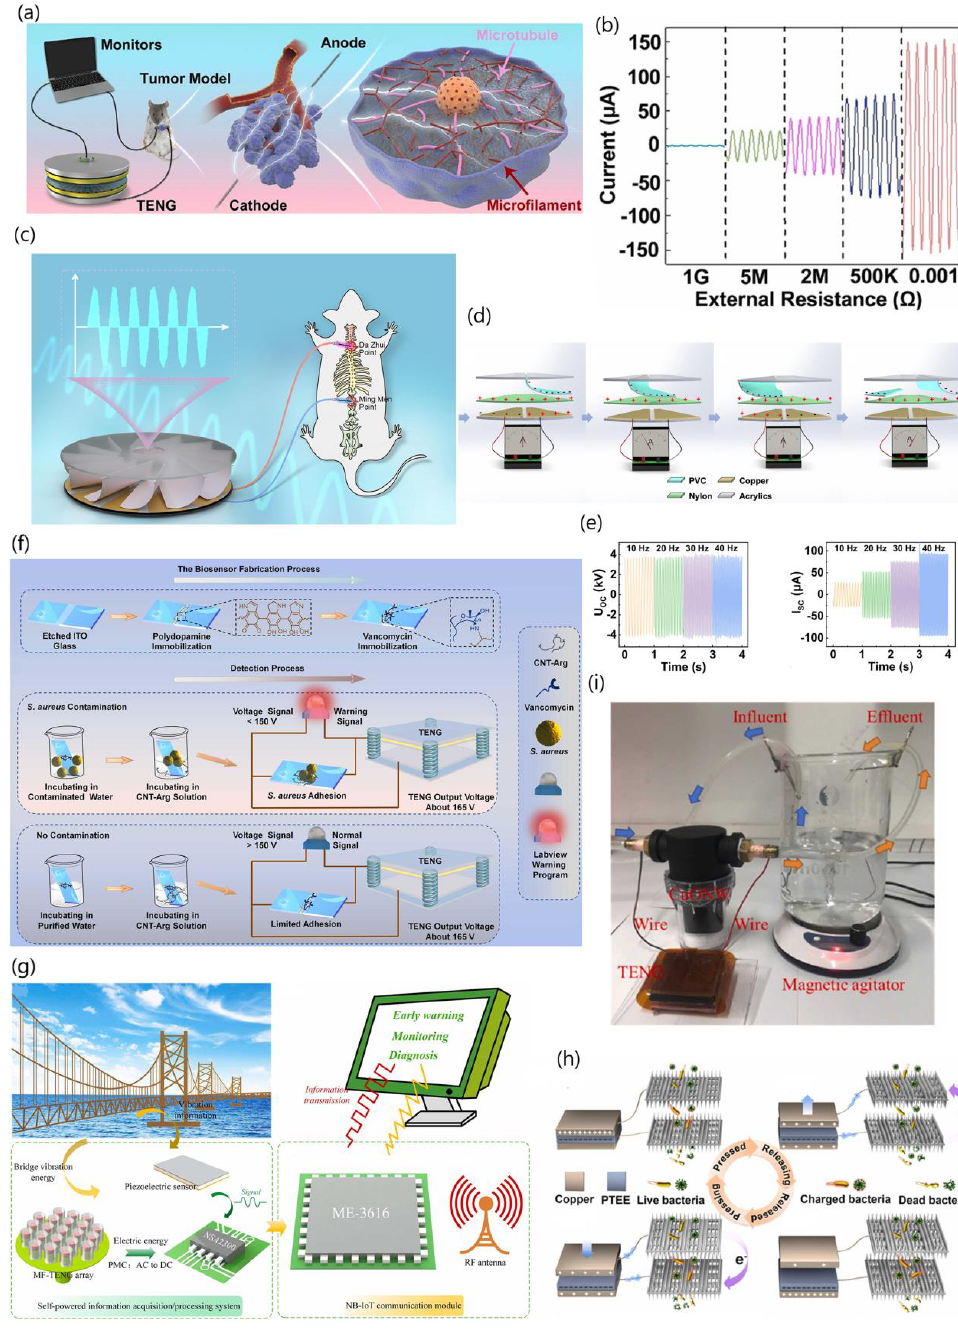
Figure 10. Application of a TENG as self-powered power supply. ( a ) Schematic illustration for the current stimulation of RD-TENG with in vivo system [93]; ( b ) Peak output current with various external resistances at a rotation speed of 120 rpm [93]; Copyright 2022, Elsevier Ltd. ( c ) Concept diagram of EA directly powered by a TENG for functional recovery after stroke, spinal cord injury [94]; Copyright 2022, Elsevier Ltd. ( d ) Working principle and electrical performance of the FS-TENG [95]; ( e ) The open-circuit (OC) voltage and short-circuit (SC) current, respectively, of the FS-TENG with different frequencies from 10 to 40 Hz [95]; Copyright 2022, American Chemical Society. ( f ) Schematic illustration of the TENG driven self-power biosensing system [96]; Copyright 2022, Elsevier Ltd. ( g ) Illustration of the self-powered bridge health monitoring framework and operating mechanism [97]; Copyright 2023, Elsevier Ltd. ( h ) Illustration of the working process of TENG [98]; ( i ) Device picture of T-NEA urine sterilization system [98]; Copyright 2022, Elsevier